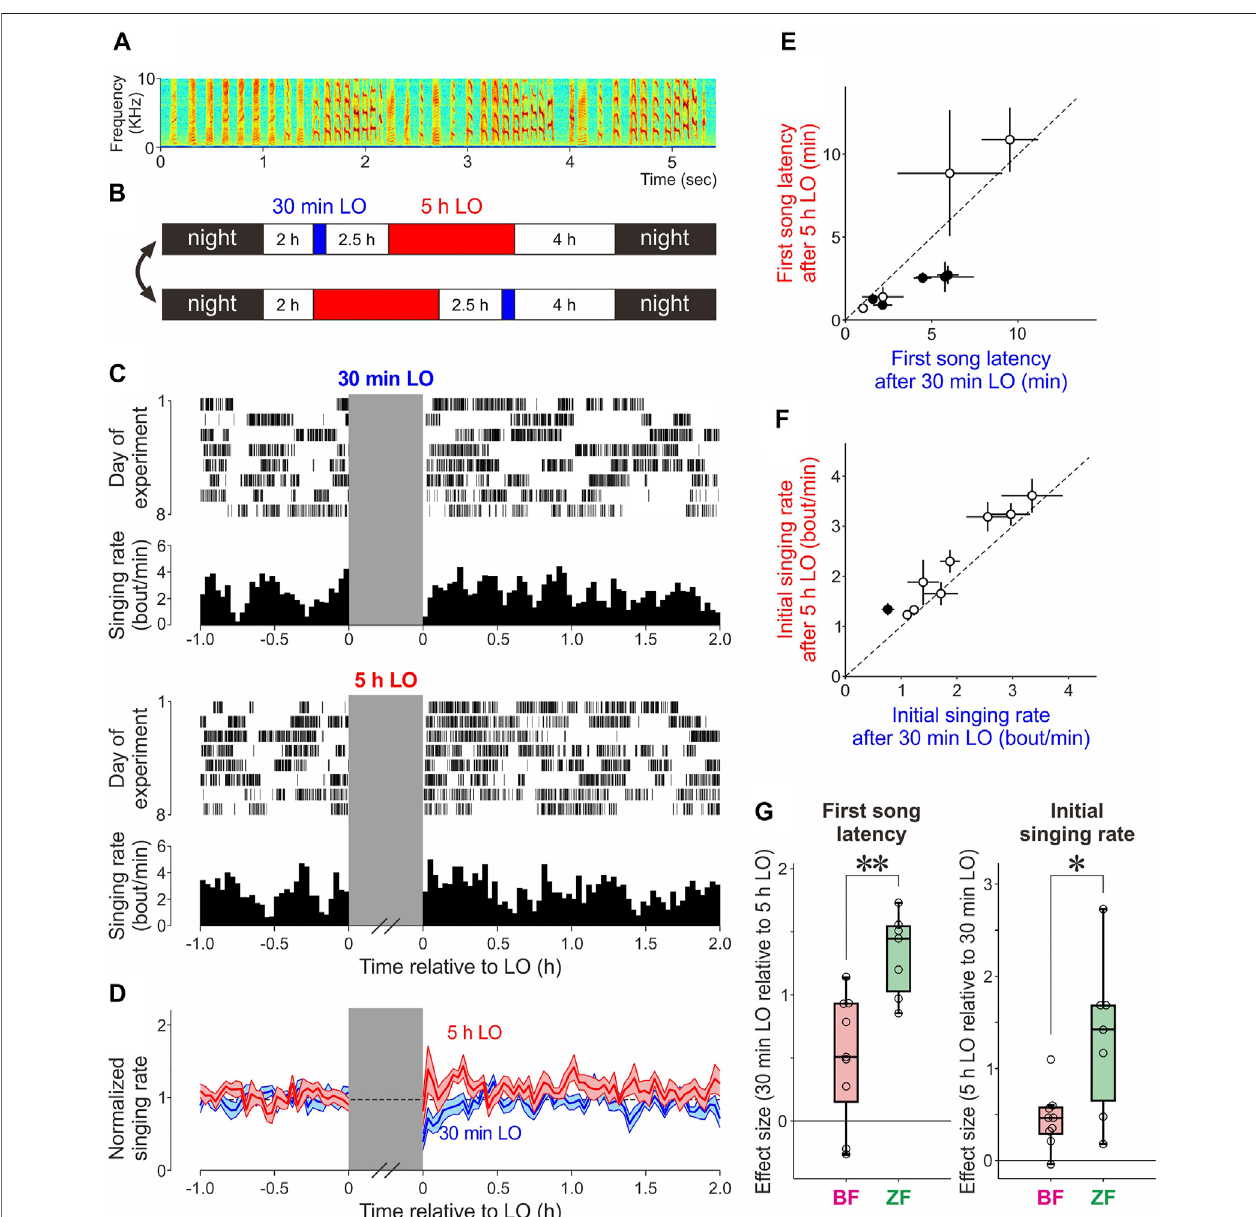
FIGURE 1 | Effects of short (30 min) and long (5 h) lights-out (LO) on undirected singing in BFs and their comparison with those in ZFs. (A) Spectrogram showing oneboutofundirectedsonginarepresentativeBF. (B) Dailyscheduleof30 minand5 hLOperiods.Aftera2 hlightperiod(whitearea)inthemorning,a30 minLO(blue area) and a 5 h LO (red area) were given with a 2.5 h intervening light period, followed by a 4 h light period. The order of the 30 min and 5 h LO was switched every 1 – 3 days. Each row indicates the schedule on one day. (C) Raster plot of song bouts produced before and after a 30 min LO (top) and 5 h LO (bottom) and corresponding singing rate histograms (bin size is 2 min) in a representative bird. (D) Time course of instantaneous singing rate before and after a 30 min (blue) and 5 h LO (red), normalized to the mean singing rate before LO (mean ± SEM, n = 9 birds). (E) The fi rst song latencies (mean ± SEM) after a 5 h LO plotted against those after a 30 min LO ( n = 9 birds). Filled circles indicate birds with statistical signi fi cance between a 5 h and 30 min LO data ( p < 0.05). The dashed lines indicate unity. (F) Initial singingratesaftera5 hLOplottedagainstthoseaftera30 minLO( n =9birds).ConventionsareasinE. (G) Theeffectsizes[Hedges ’ gforthe fi rstsonglatency(left)and the initial singing rate (right) between a 30 min and 5 h LO in BFs and ZFs. * p < 0.05; ** p < 0.01].